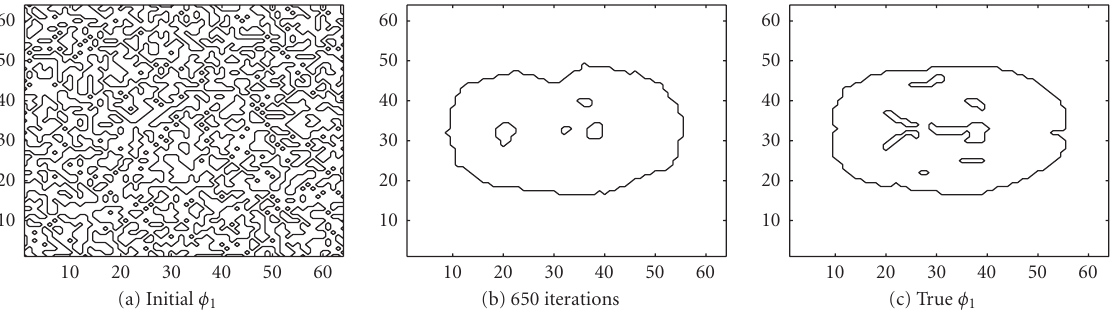
Figure 12: Interfaces given by the zero level set of φ 1 .